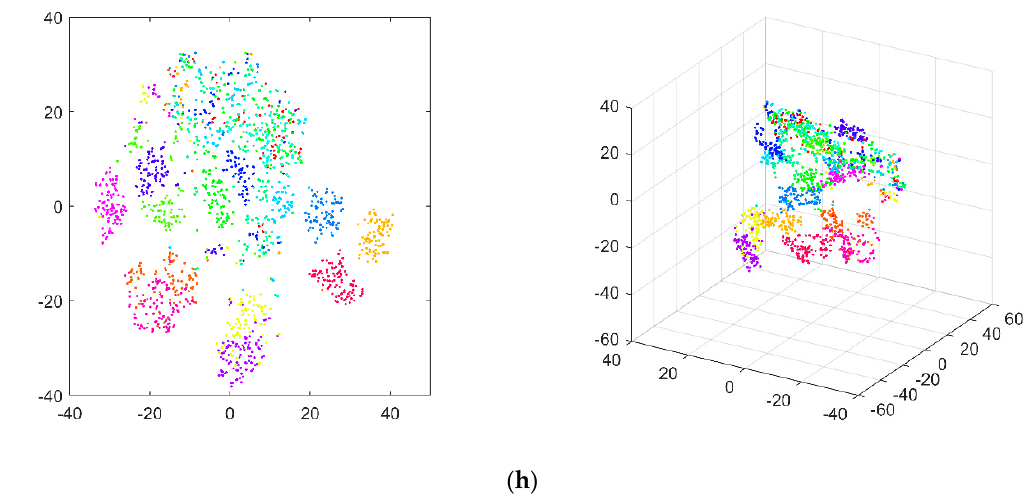
Figure 11. Visualization results of the damage features in the TFs extracted by the 1D CNN model, under the noise levels of the signal-to-noise ratio (SNR) = ( a ) 50, ( b ) 40, ( c ) 35, ( d ) 30, ( e ) 25, ( f ) 20, ( g ) 15, and ( h ) 10 dB.